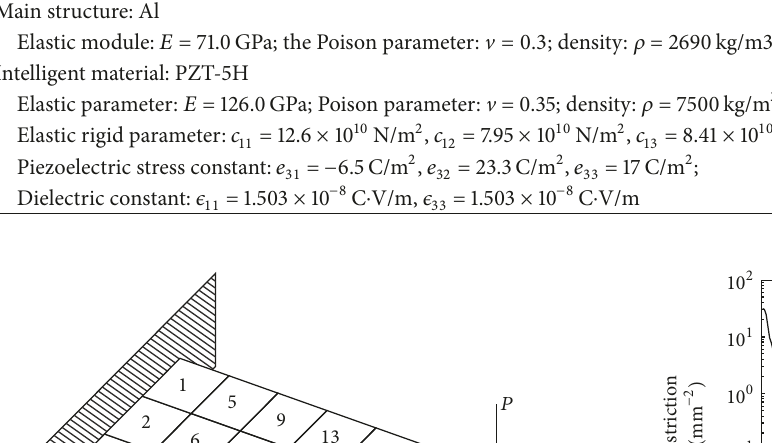
Table 1: Property parameters of cantilever intelligent structural plate.